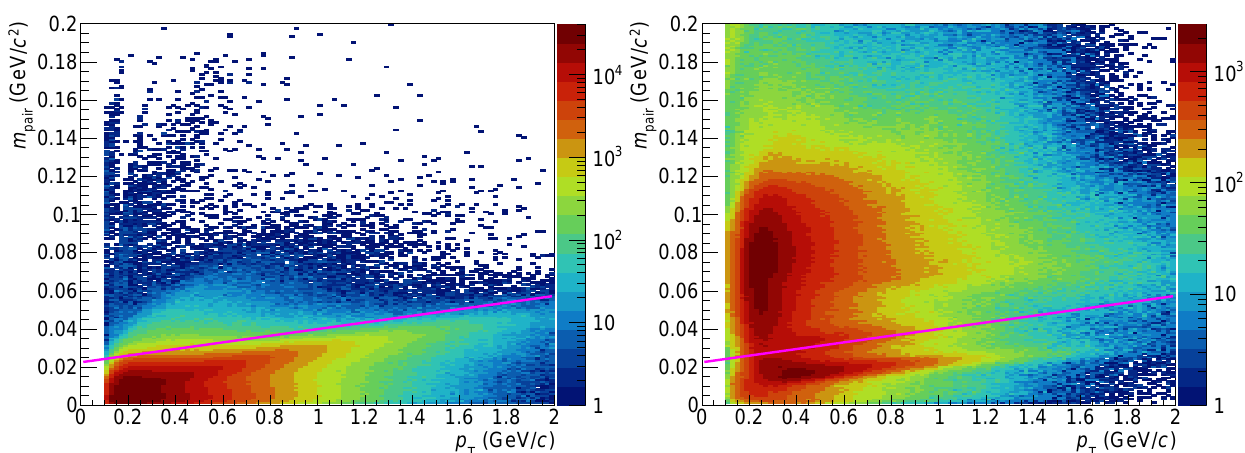
Figure 5. Distributions of signal ( left ) and background ( right ) pairs as a function of invariant mass and transverse momentum of the reconstructed pair. Selection limits are shown with magenta lines.